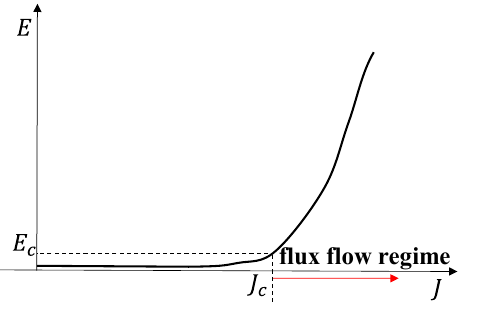
Figure 14. Visualization of the E-J relation, the red arrow means that the flux flow regime appears after transport current exceeds the critical current density.